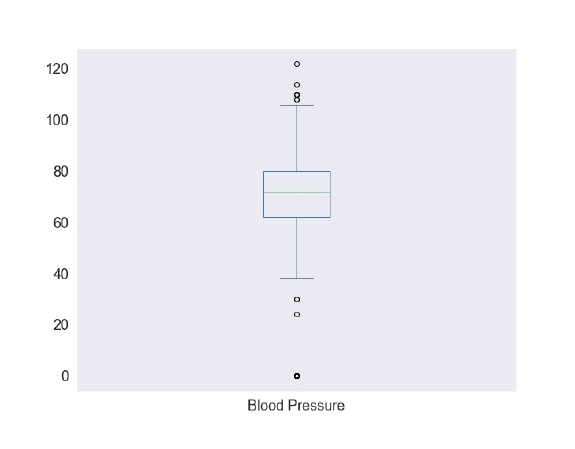
Figure 11. Box Plot for Attribute ‘Blood Pressure’ in PID Dataset